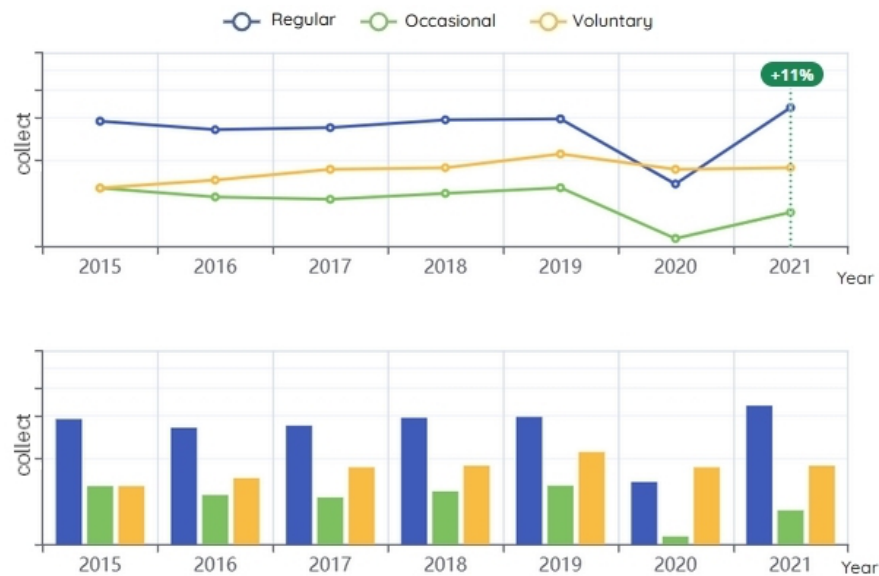
Figure 8. Blood collected per year (whole blood and